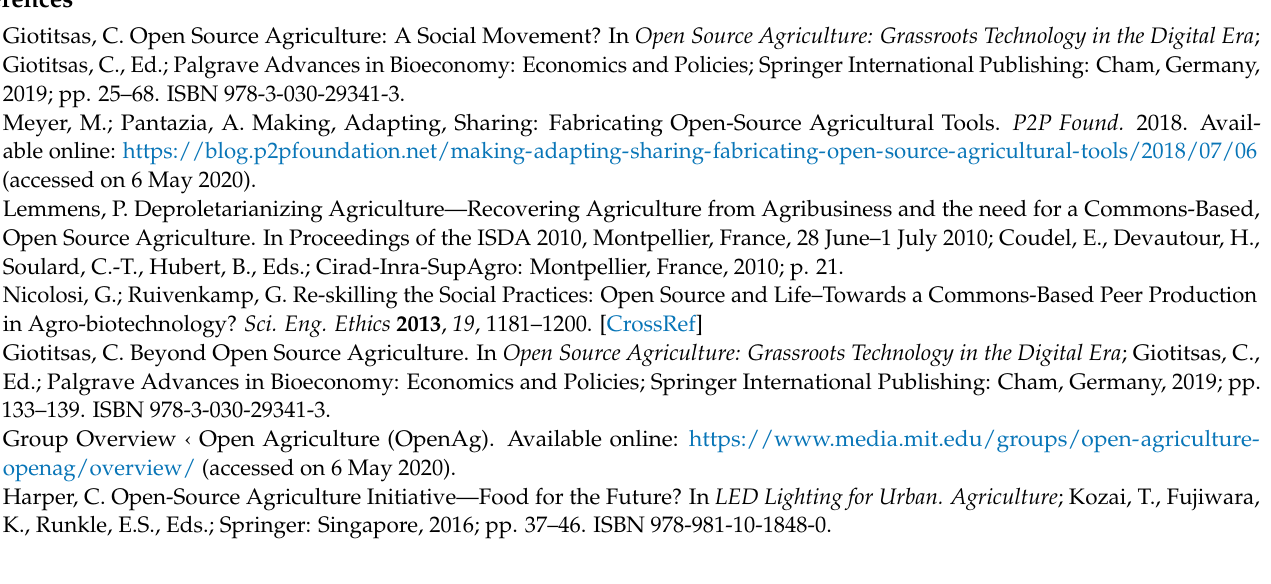
Figure A4. Finished and labeled rendering of the spacer. The spacer design is simple, consisting of a cylinder with a clearance bore through the middle that accommodates the central screw assembly. Along the ring of the spacer are bore holes that act as simple bearings for the rollers. These bearings allow the rollers to roll and make slight shifts in angle while maintaining a safe distance between the roll- ers.